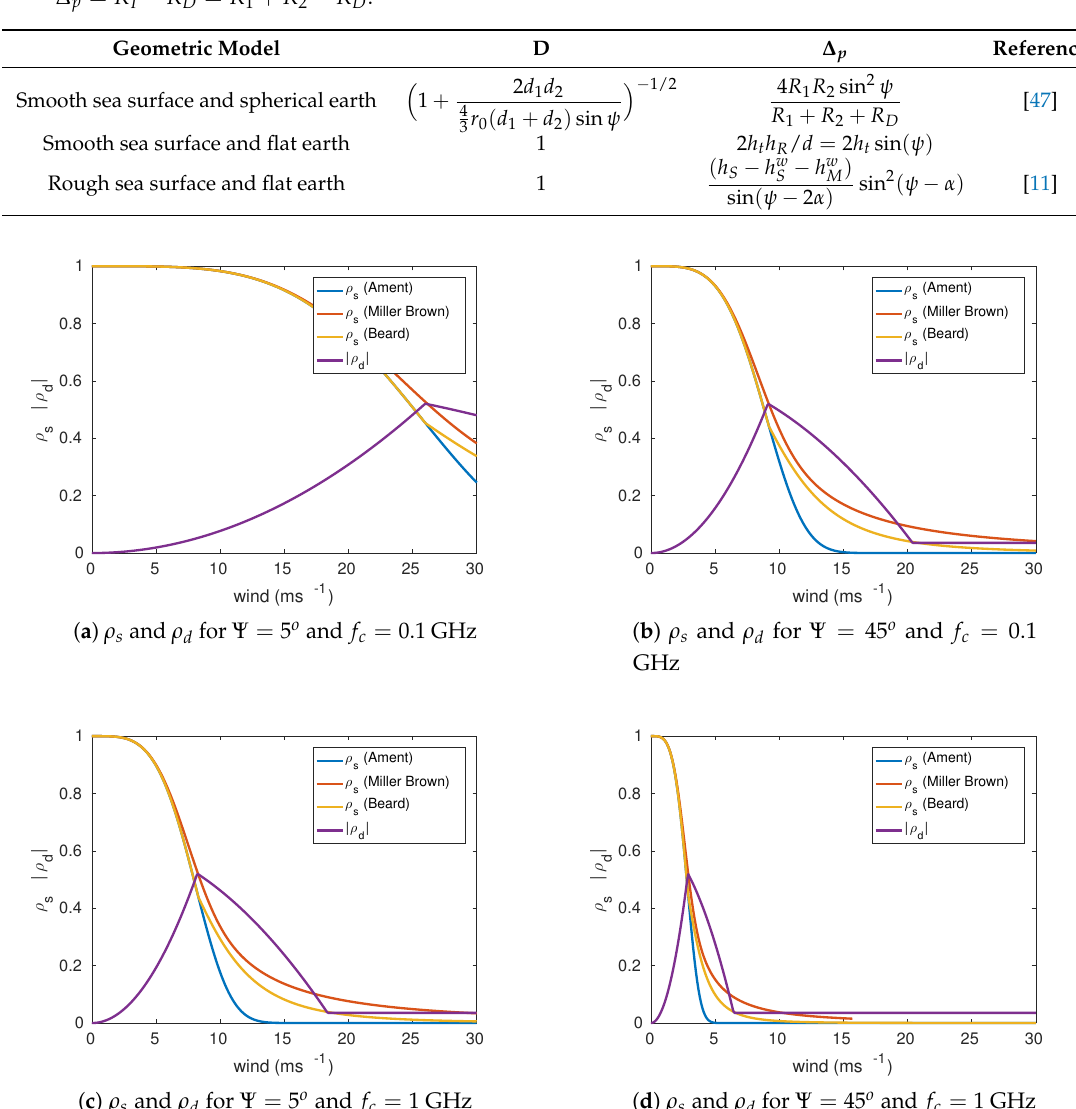
Figure 3. ρ s and | ρ d | values for different grazing angles and radar